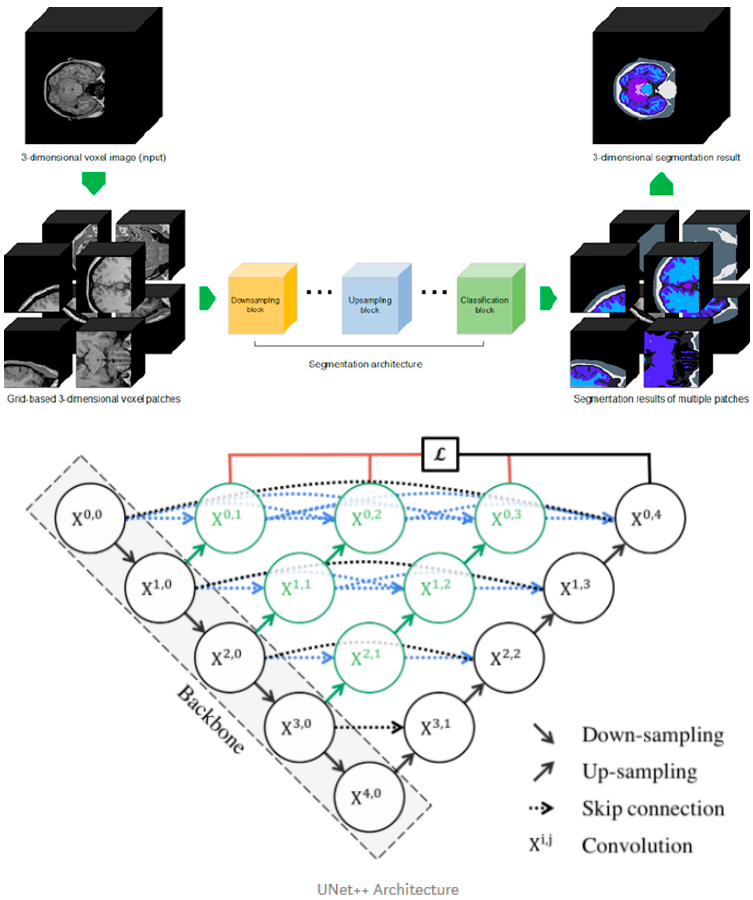
Figure 2. Three-dimensional patch-based training scheme explanation ( upper ) and Improved U-Net++ architecture ( bottom ). For the training dataset, we performed Desikan–Killiany atlas-based FreeSurfer seg- mentation on 388 patients from public datasets including HCP, ADNI, PPMI, AIBL, and IXI, and two experts performed manual correction to produce a fine-tuned gold standard. Among the entire data set, we first randomly shuffled and set aside 49 datasets for testing. The remaining data were then categorized for training and validation (9.5:0.5). The train- ing data were constructed by extracting the three-dimensional patch image using uniform sampling (96 × 96 × 96) for the individual ground truth data (Figure 2, upper). With the aforementioned training parameters, the model was iteratively trained 500,000 times. The batch size was set to 1, which was the limit that could be handled by the 11 GB RAM of